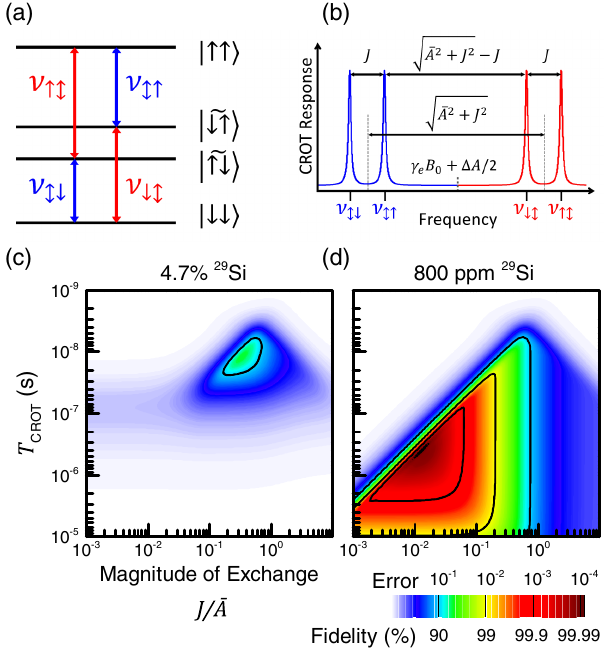
FIG. 2. (a) Schematic of the level diagram for the two-donor system with the nuclei prepared in the j ⇓⇑ i state. (b) Schematic of the corresponding ESR spectrum. (c),(d) Contour plots of the fidelity of the proposed CROT gate as a function of J and T calculated on the basis of the experimental values of the ESR line widths in (c) natural silicon and (d) isotopically purified